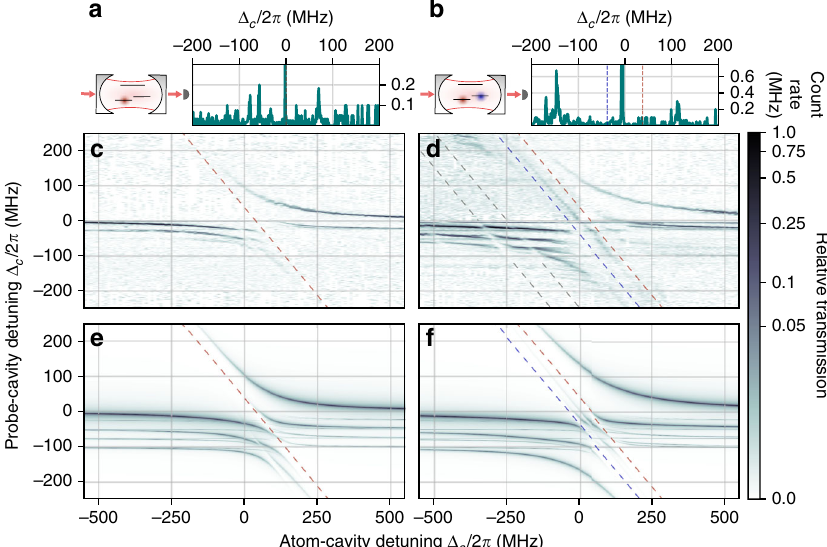
Fig. 2 Transmission spectrum of a unitary Fermi gas strongly coupled to light. a , b Schematic view of the experiment, depicting the three relevant energy levels and cavity transmission signal, averaged over three realizations, as a function of Δ c /2 π , for Δ a /2 π = 38.2 MHz for a spin-polarized Fermi gas with N ↑ = 9.1(7) × 10 4 and N ↓ = 2(1) × 10 3 ( a ) and for Δ a = 0 for a spin-balanced Fermi gas of 2.0(1) × 10 5 atoms equally populating each spin state ( b ). The values of Δ a are centered on the anticrossing feature for both cases. c , d Coupled-system transmission spectrum as a function of Δ c /2 π and Δ a /2 π for the spin-polarized ( c ) and spin-balanced Fermi gas ( d ). The transmissions normalized by the maximum observed in each case are displayed in logarithmic scale. The bare atomic transitions for "j i and #j i are shown with red and blue dashed lines, respectively. The grey dashed lines indicate a weak contribution attributed to molecular states. e , f Transmission spectra obtained from ab initio calculation accounting for the higher-order transverse mode contributions for the spin-polarized ( e ) and the spin-balanced gases ( f